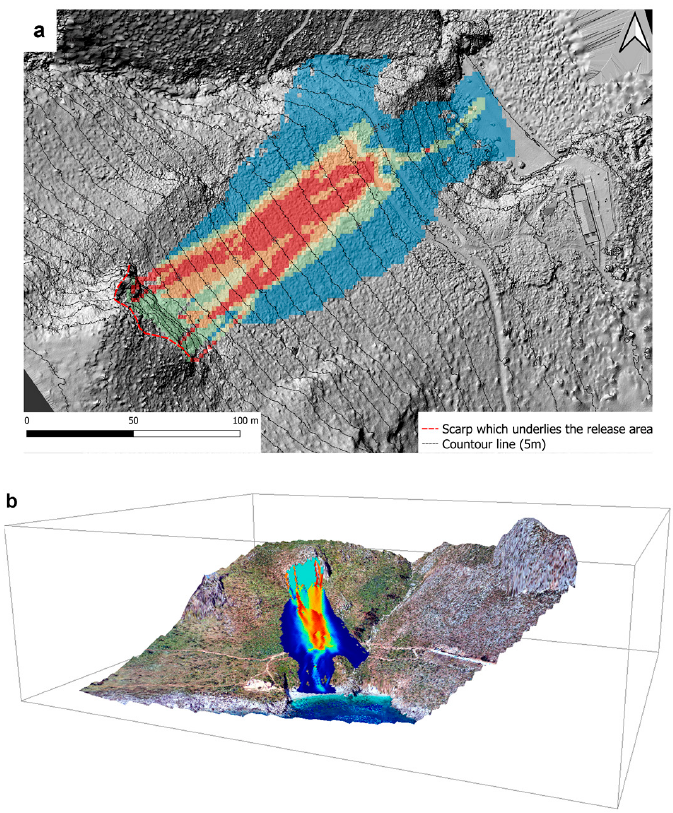
Figure 14. Runout area obtained by applying the empirical method using GPP in SAGA GIS: ( a ) in plan and ( b ) in 3D